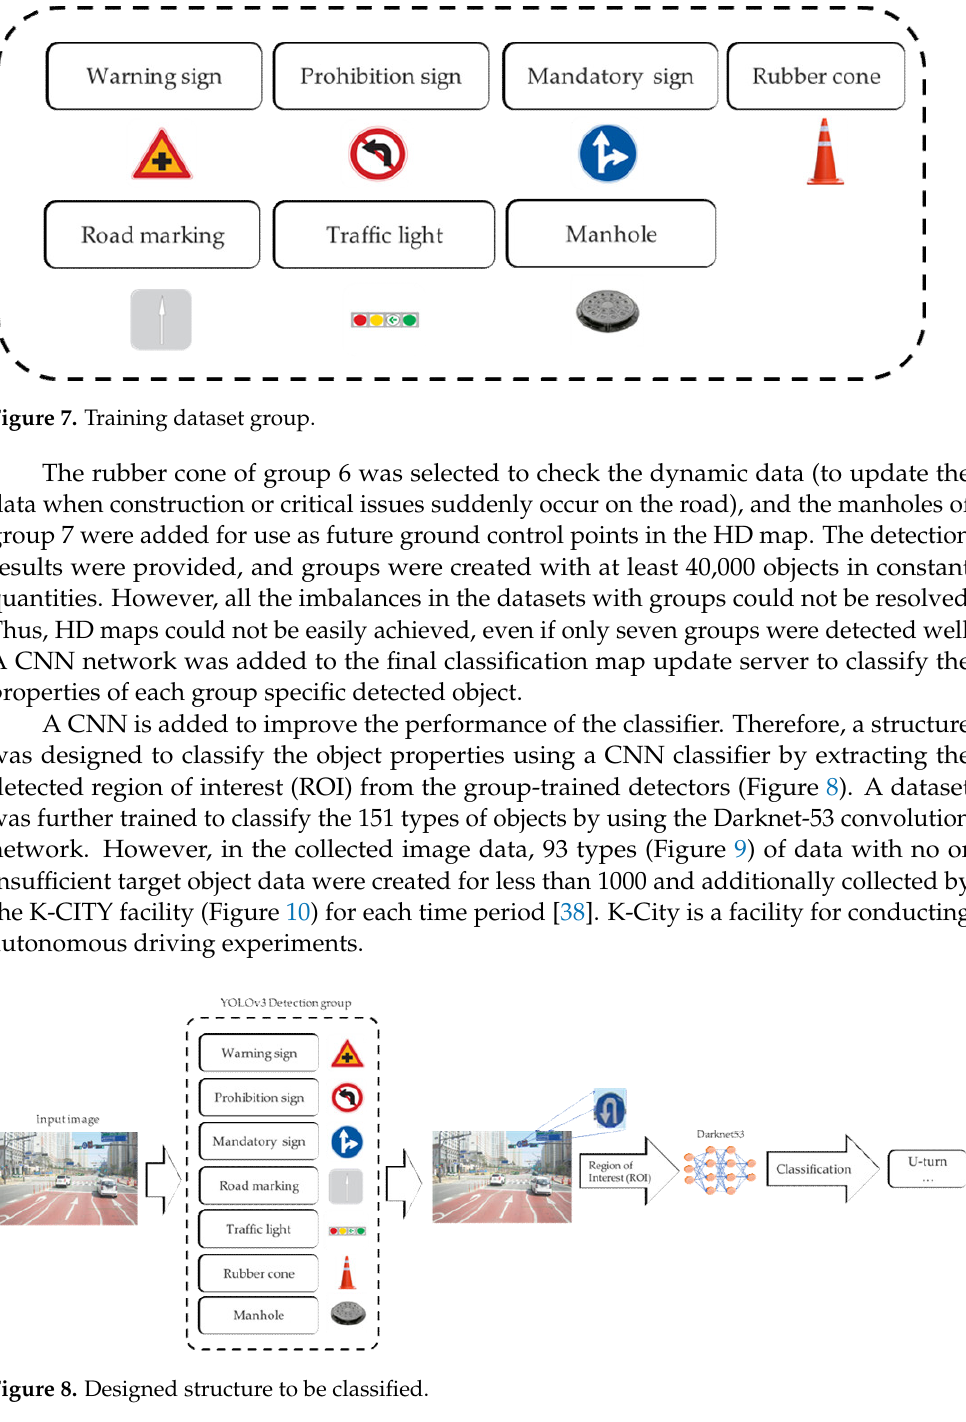
Figure 9. Illustration of 93 traffic signs with no or less than 1000.